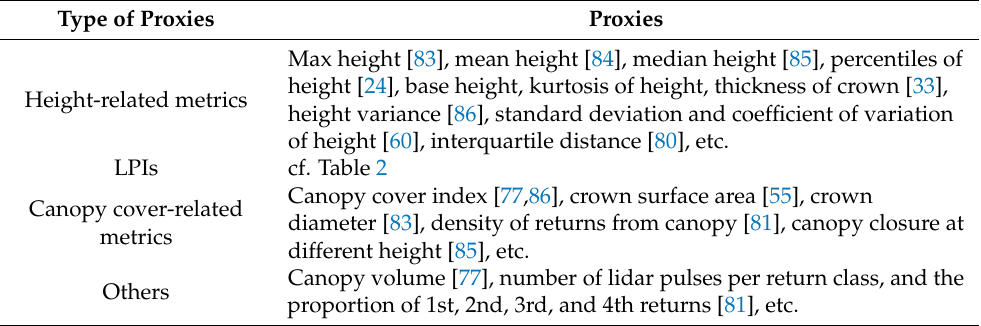
Table 3. Widely used proxies for the empirical regression